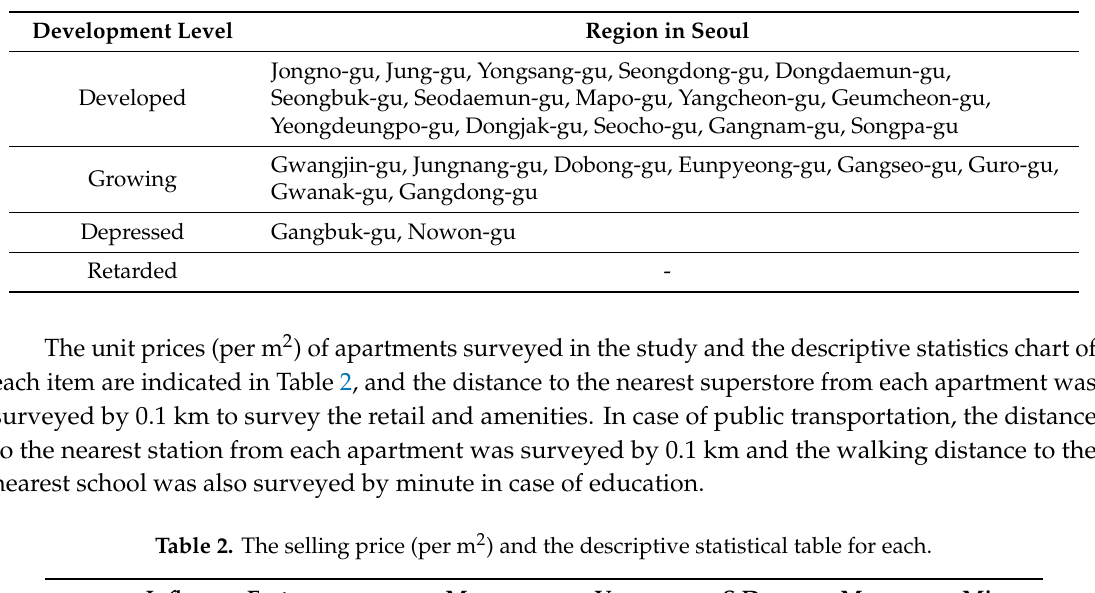
Table 1. The regional backwardness of the Seoul [15].